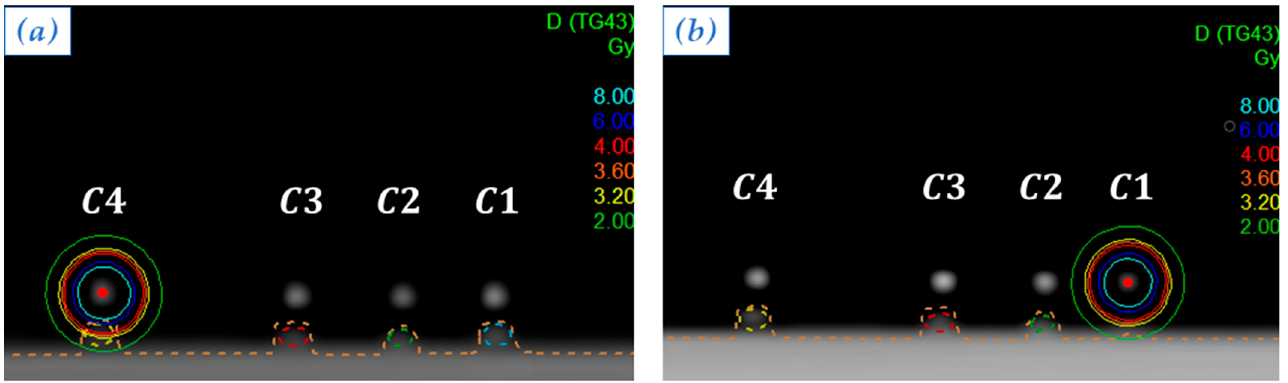
Figure 4. Isodose curves obtained by optimizing the plan with a single active dwell position in C4 ( a ) and the plan with a single active dwell position in C1 ( b ). Each color corresponds to a dose value, as reported in the legend Both plans were delivered five times to test the set-up reproducibility.